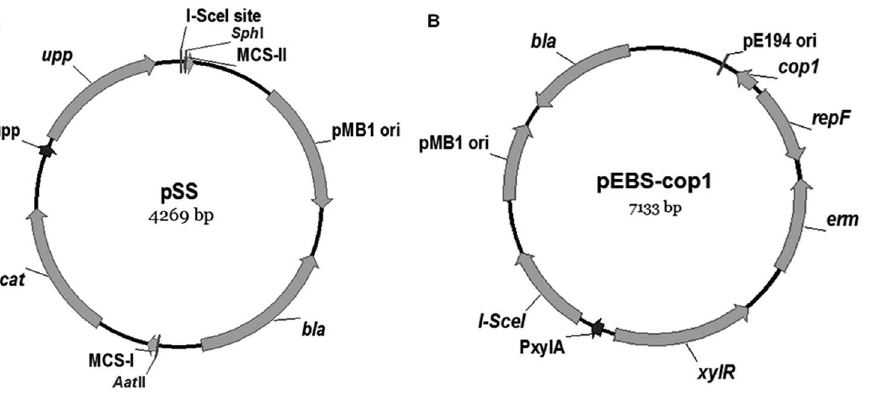
Figure 1. Plasmids for genetic modification in B.subtilis . (A) A modular cassette was cloned into pUC18 to generate pSS, the modular cassette contained chloramphenicol resistance gene ( cat ), UPRTase encoding gene ( upp ) and the recognition site of I-S ce I endonuclease at 3 9 end of upp gene. (B) The xylose-inducible I-S ce I cassette was cloned into pEB, with a temperature-sensitive replicon ( repF ) and erythromycin resistance gene ( erm ). doi:10.1371/journal.pone.0081370.g001 PLOS ONE |